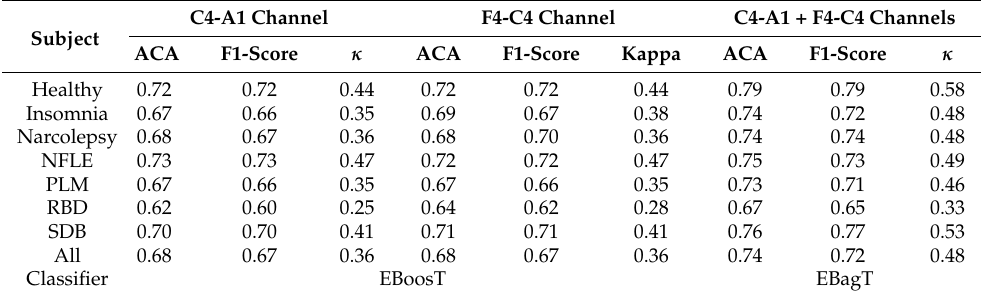
Table 13. Performance parameters obtained for CAP Phase A detection in different types of sleep disorder subjects using both EEG channels for 1-sec epoch